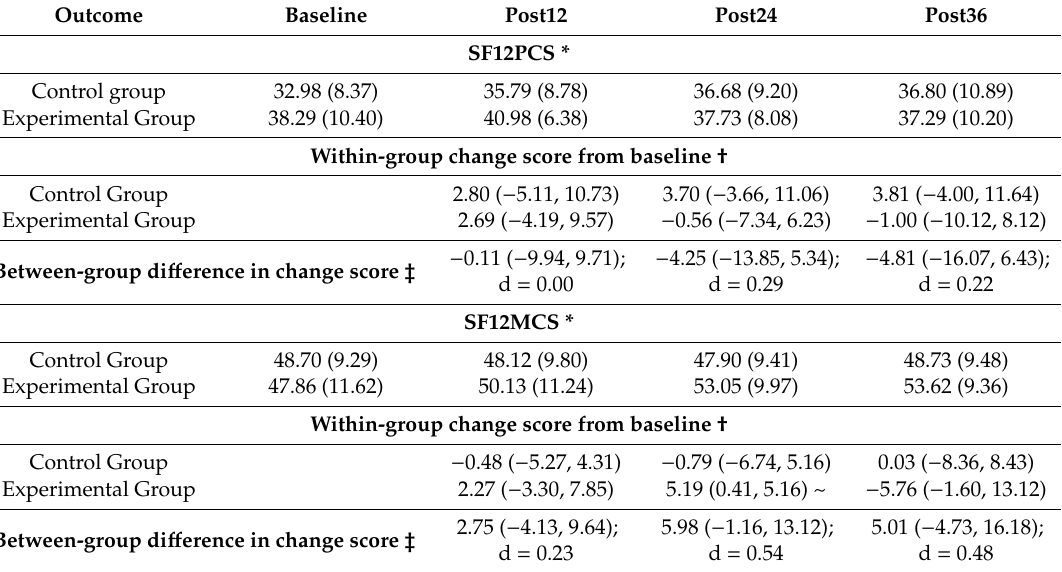
Table 5. SF12 questionnaire